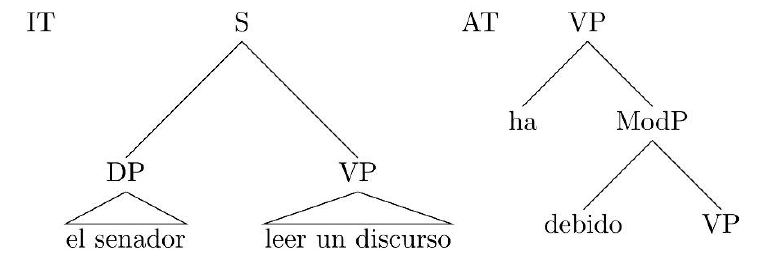
Figure 11. Elementary trees for ‘El senator ha debido leer un discurso’ Figure 11. Initial and Auxiliary Trees for ‘El senator ha debido leer un discurso’